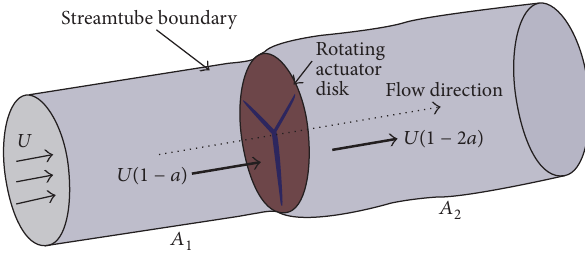
Figure 5: Schematic of momentum